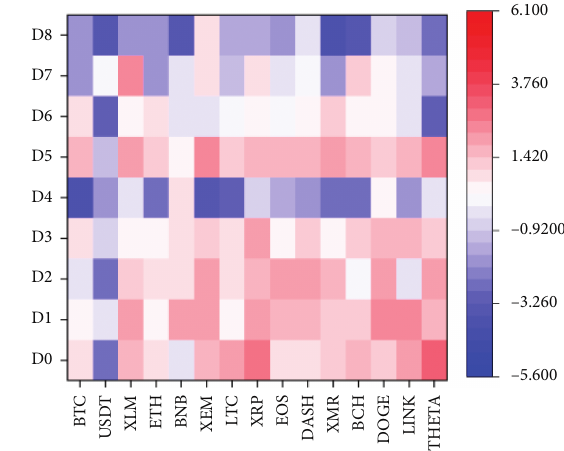
Figure 23: VET to the other.